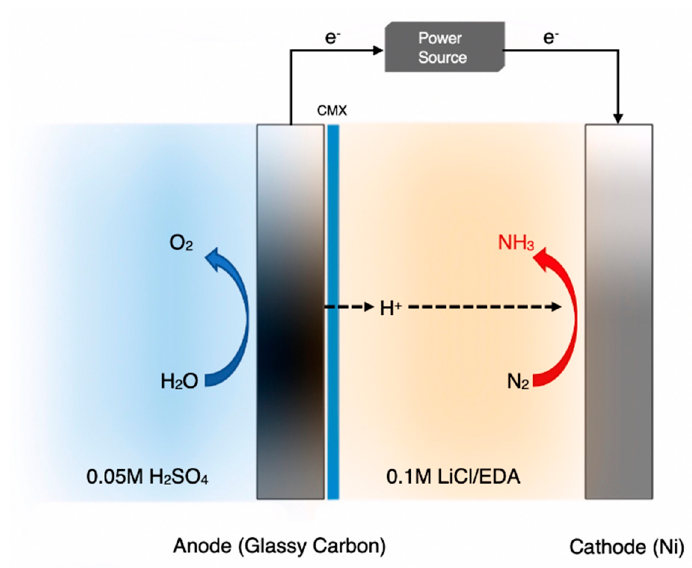
Figure 6. Schematic diagram of the ethylenediamine (EDA)-based cell for the electrochemical synthesis of NH 3 . Redrawn from [53].